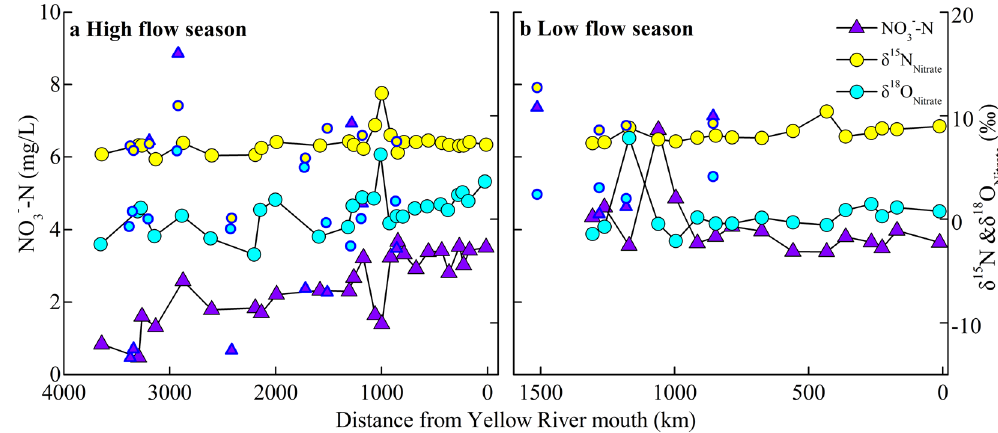
Figure 2. The distance variation of [NO 3 − –N] and nitrate isotopes in Yellow River, scatter symbol indicates tributary